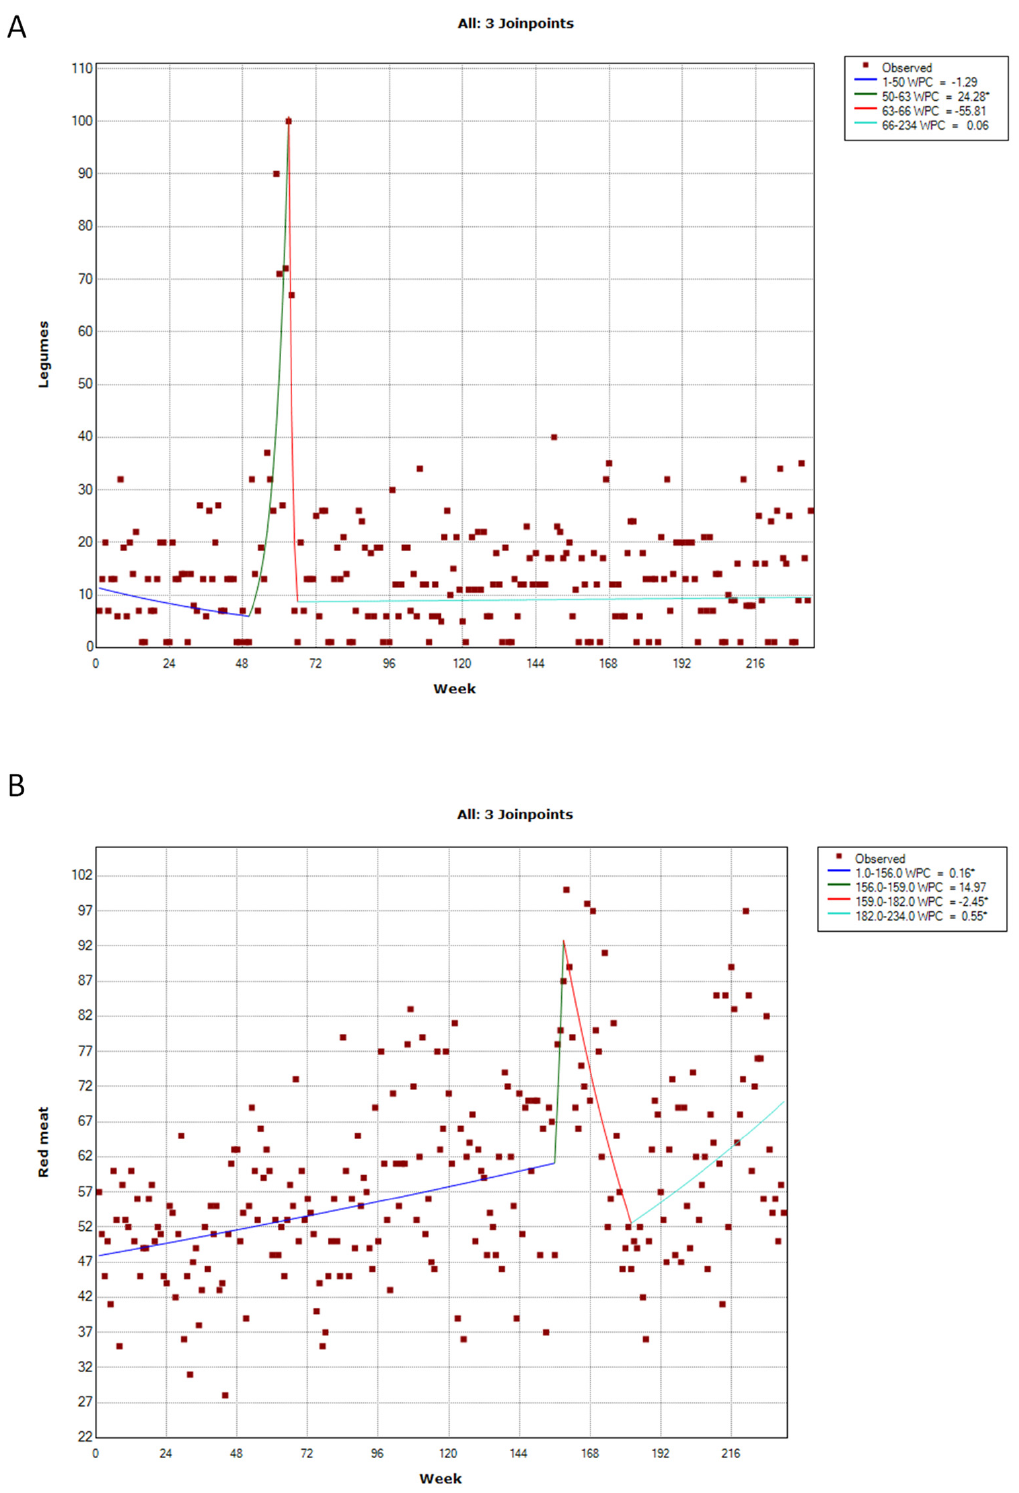
Figure 4. Joinpoint analysis of public interest in legumes ( A ) and red meat ( B ). * p -value < 0.05. The analysis of public interest in red meat also detected three joinpoints that, however, were differentially located in the time series. The interest in red meat, in fact, exhibited a slight increase (WPC = 0.16%) from 1 January 2018 to 27 December 2020 (i.e., the first joinpoint detected by the analysis on the 156th week; 95% CI = 132–179), which became more marked (WPC = 14.97%) up to the highest peak reached during the week from 10